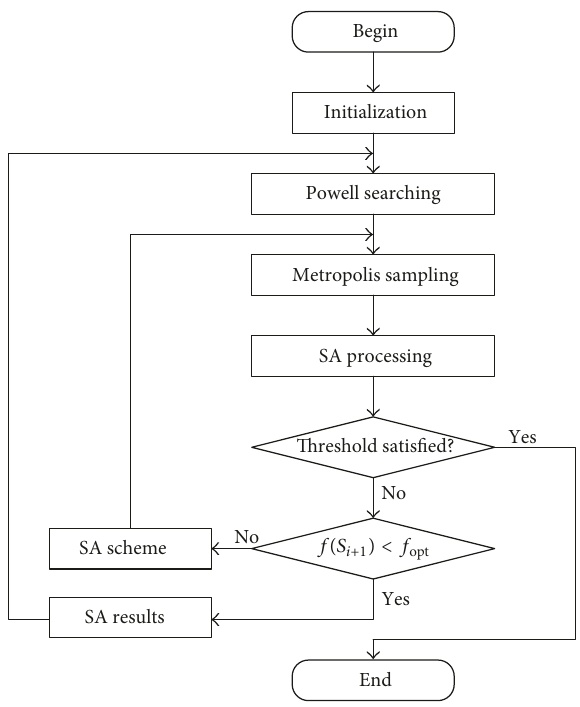
Figure 2: Flow chart of the PSACO